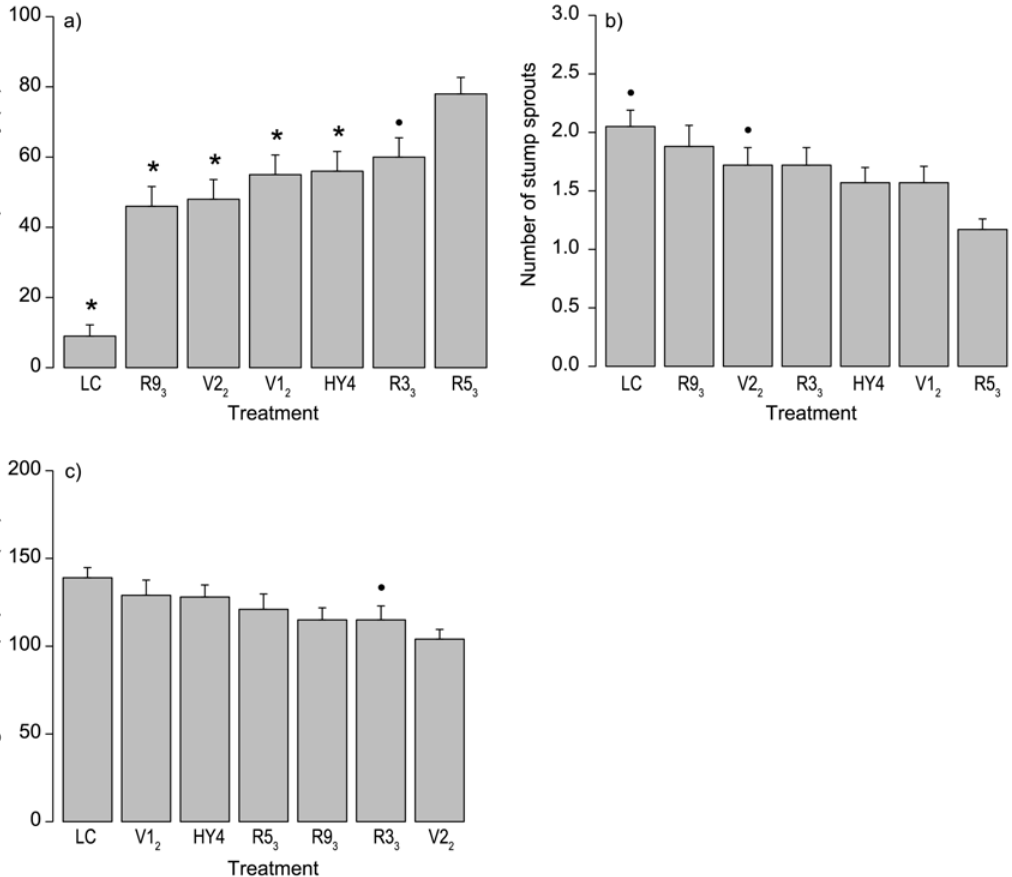
Fig 3. The Effects of Different Treatments on Birch Sprouting during Phase 4. The effects on a) the mortality of stump sprouts ( n = 560), b) the number of stump sprouts in living stumps ( n = 279), and c) the maximum height of stump sprouts in living stumps ( n = 279) of birch ( Betula pendula and B . pubescens ) three growing seasons (autumn 2013) after the treatments. Means with standard errors are presented. Statistically significant differences between the C . purpureum strain R5 3 and other treatments are indicated with an asterisk ( p < 0.05) or a dot (0.05 (cid:3) p (cid:3) 0.10). See Tables 4 –